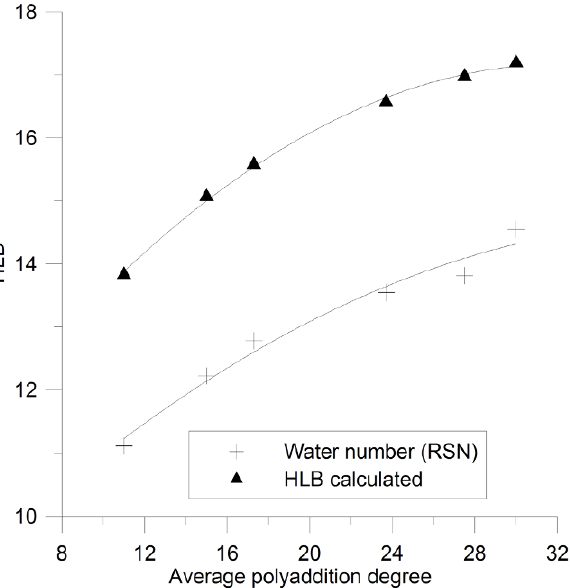
Figure 5. Comparison of the theoretical HLB ( Griffin ) and the experimental water number ( Greenwald, RSN ) values, as determined for the studied samples of ethoxylates of the C12